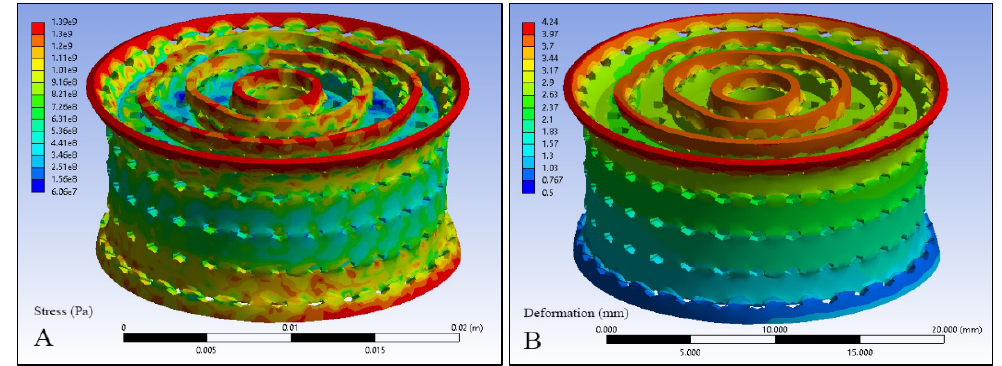
Figure 7 . Honeycomb scaffold simulation: ( A ) Stress and ( B ) displacement (final height after compression 15 − 4.24 = 10.76 mm; red dots are separated particles in contact with compressive punches).